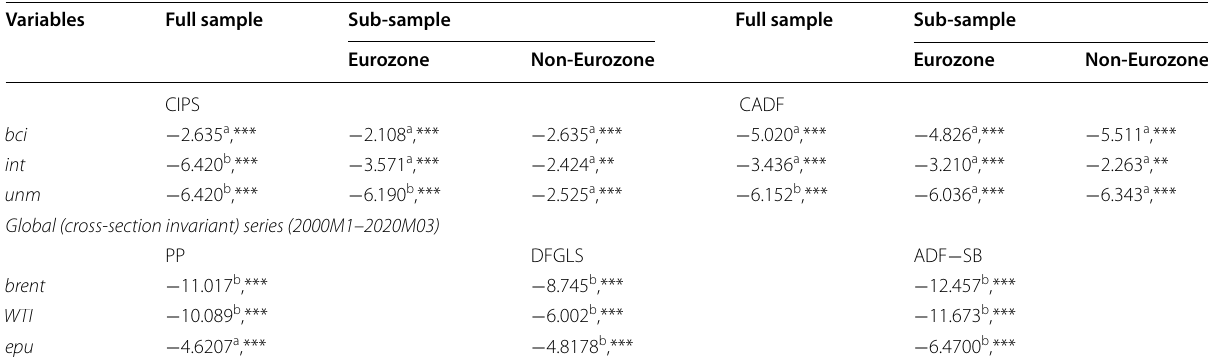
Table 3 Unit root tests